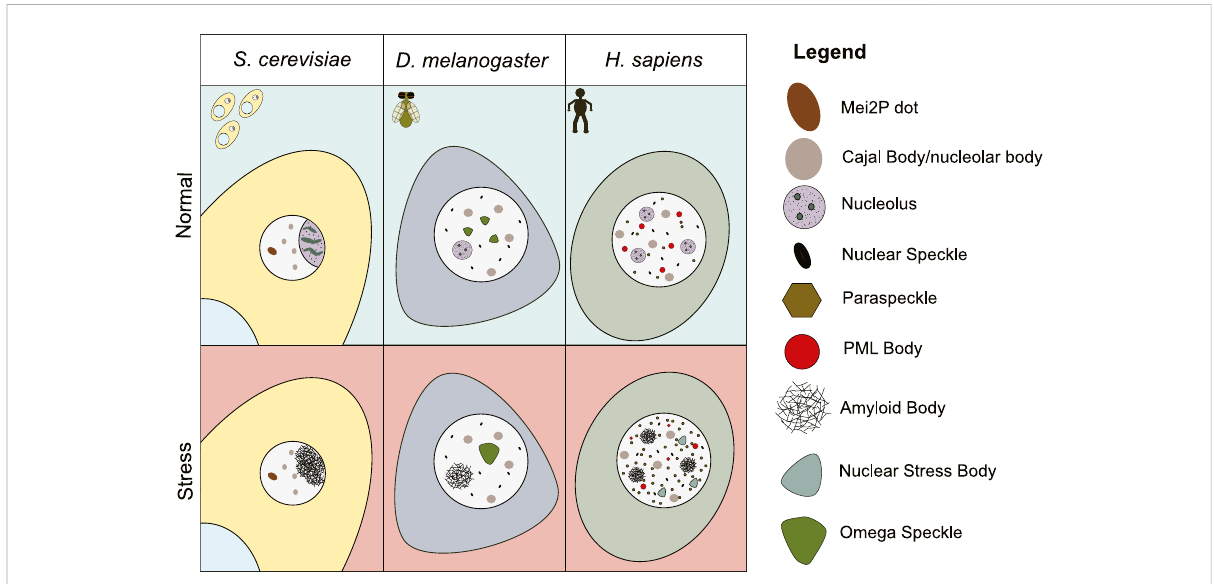
FIGURE 1 Schematic representation of a yeast, fl y, and human cell in normal, or environmental stress conditions. Nuclear biomolecular condensates that are present under these conditions are